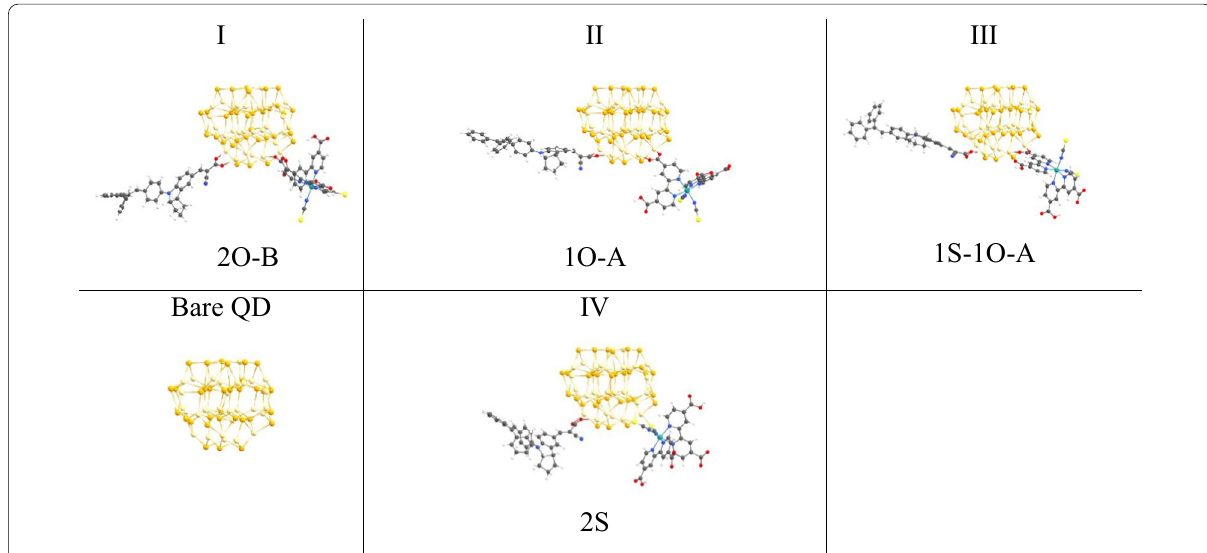
Fig. 2 Representative geometries of the bare Cd 33 Se 33 QD and N719-D131@Cd 33 Se 33 composite. The geometry optimization was performed in vacuum